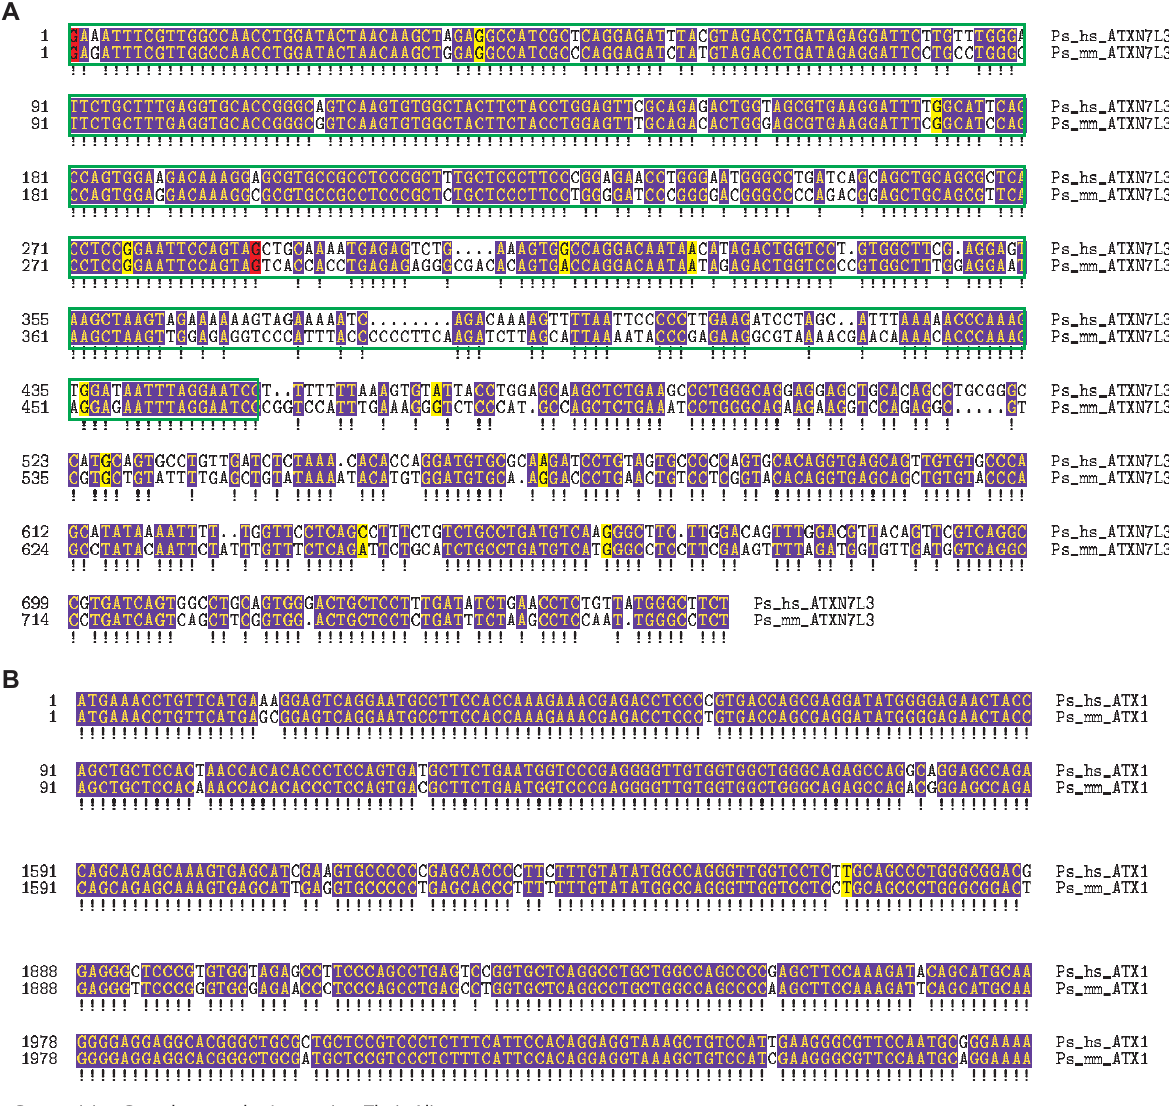
Figure 9. Recognizing Pseudogenes by Inspecting Their Alignment (A) An alignment, visualized with TeXshade [34], of the processed copies to the ATXN7L3 human and mouse protein-coding genes. The human as well as the mouse ATXN7L3 contains 12 exons, which are all present in the respective duplicates. Approximate exon borders are shown in yellow. The most interesting part consists of columns 1–468 (boxed green), which according to several EST and mRNA sequences is the only segment expressed. It consists of a highly conserved part, 1–288 (red), which is a potential open reading frame, followed by part 289–468 with pseudogenic disablements. (B) Selected parts of the alignment of the ATX1 copies which are also processed. The protein-coding genes contain eight exons of which only parts of the last two code for protein. The entire segment of the pseudogenes corresponding to the protein-coding parts of the genes is expressed. The possibility that the processed copies are protein-coding cannot not be completely ruled out, however. Indeed, each pseudogene consists of one single 2,068-bp-long open reading frame. However, the frame induced by the alignments to the protein-coding genes contains several